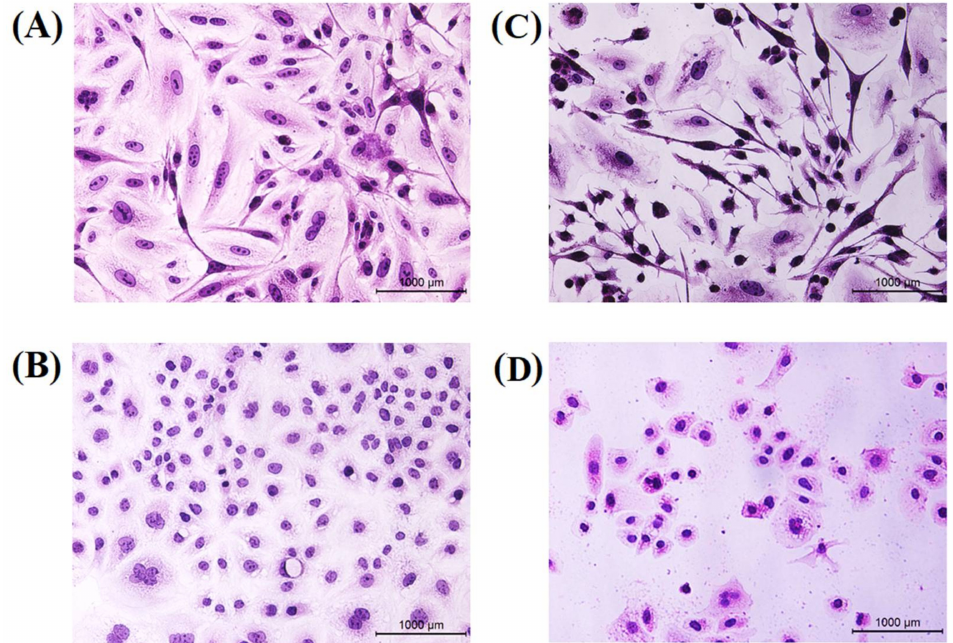
Figure 12. Morphological changes of hematoxylin and eosin. MCF-7 cell line (upper lane) and CAL-51 cell line (lower lane) were treated with IC 50 concentration of TAM/RES–LbL-LCNPs for 24 h. ( A , B ) Non-treated cells show normal structure without prominent apoptosis at MCF-7. CAL-51, respectively ( C , D ) Cells treated with TAM/RES–LbL-LCNPs; apoptotic cells show condensed, and fragmented nuclei were recorded at MCF-7. CAL-51,